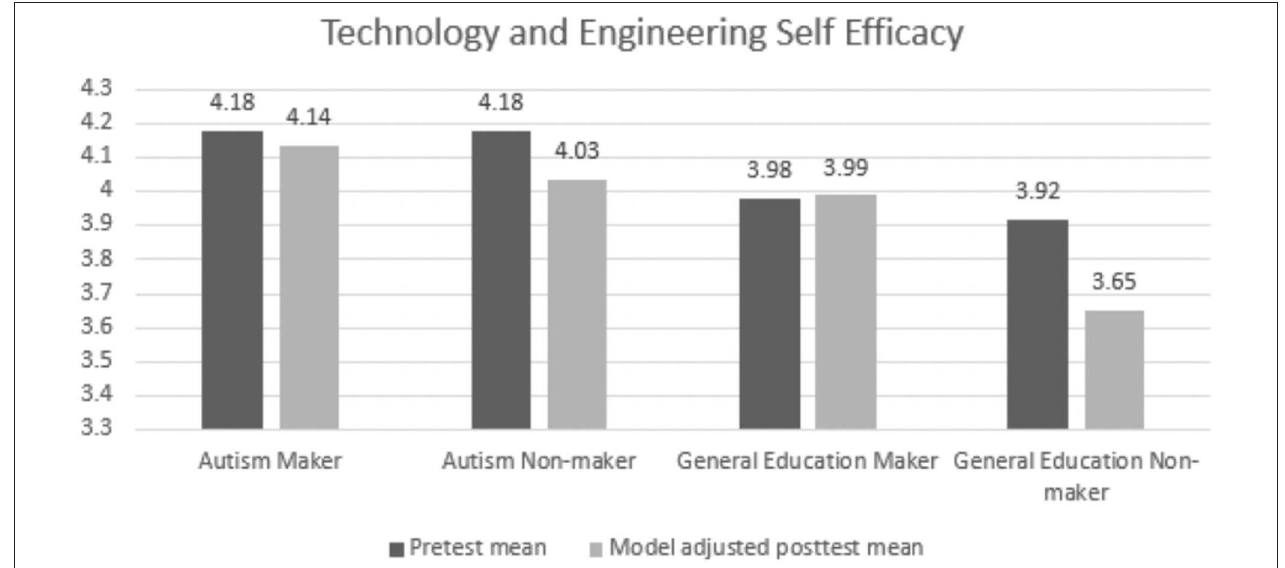
FIGURE 2 | Estimated means for the Technology and Engineering Self-Efficacy construct.